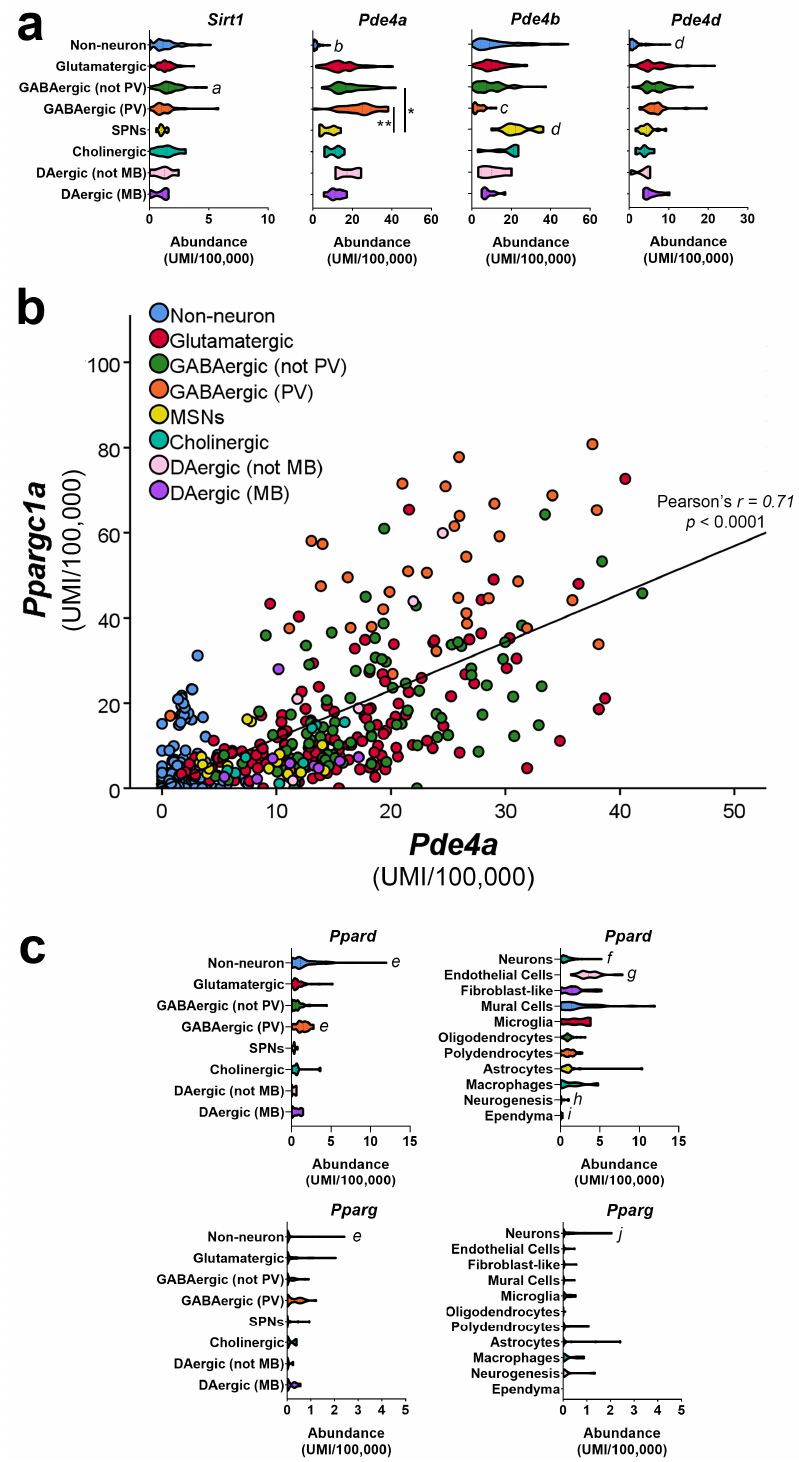
Figure 3. ( a ) A publicly available single-cell transcriptomic dataset [64] was used to explore cell-type- specific mRNA abundance of putative drug targets for manipulation of PGC-1 α expression and/or activity. While Sirt1 mRNA expression is low and ubiquitous, other transcripts which are putative targets of resveratrol are expressed more abundantly and in different cell-type-specific distributions. Note the difference in the x-axes scales. ( b ) A strong correlation was observed between the cell-type- specific abundance of Ppargc1a and Pde4a mRNA. ( c ) Ppard shows differential enrichment in neuronal and non-neuronal populations, while Pparg is expressed relatively lowly at the mRNA level. Note